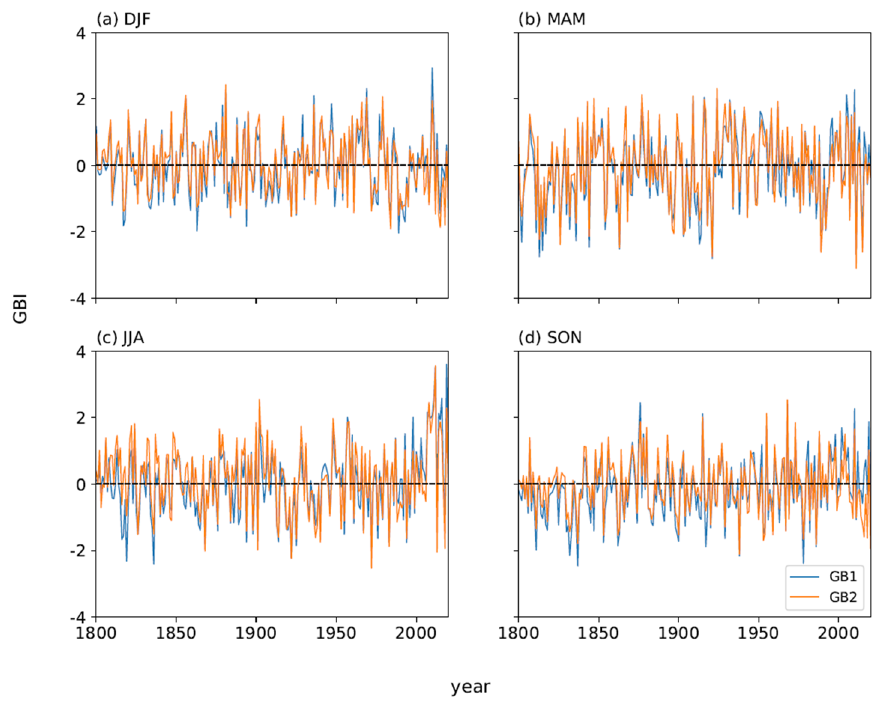
Figure 3. Seasonal series for 1800–2020 of the two GBI series (GB 1 and GB 2 ) for ( a ) winter (DJF), ( b ) spring (MAM), ( c ) summer (JJA) and ( d ) autumn